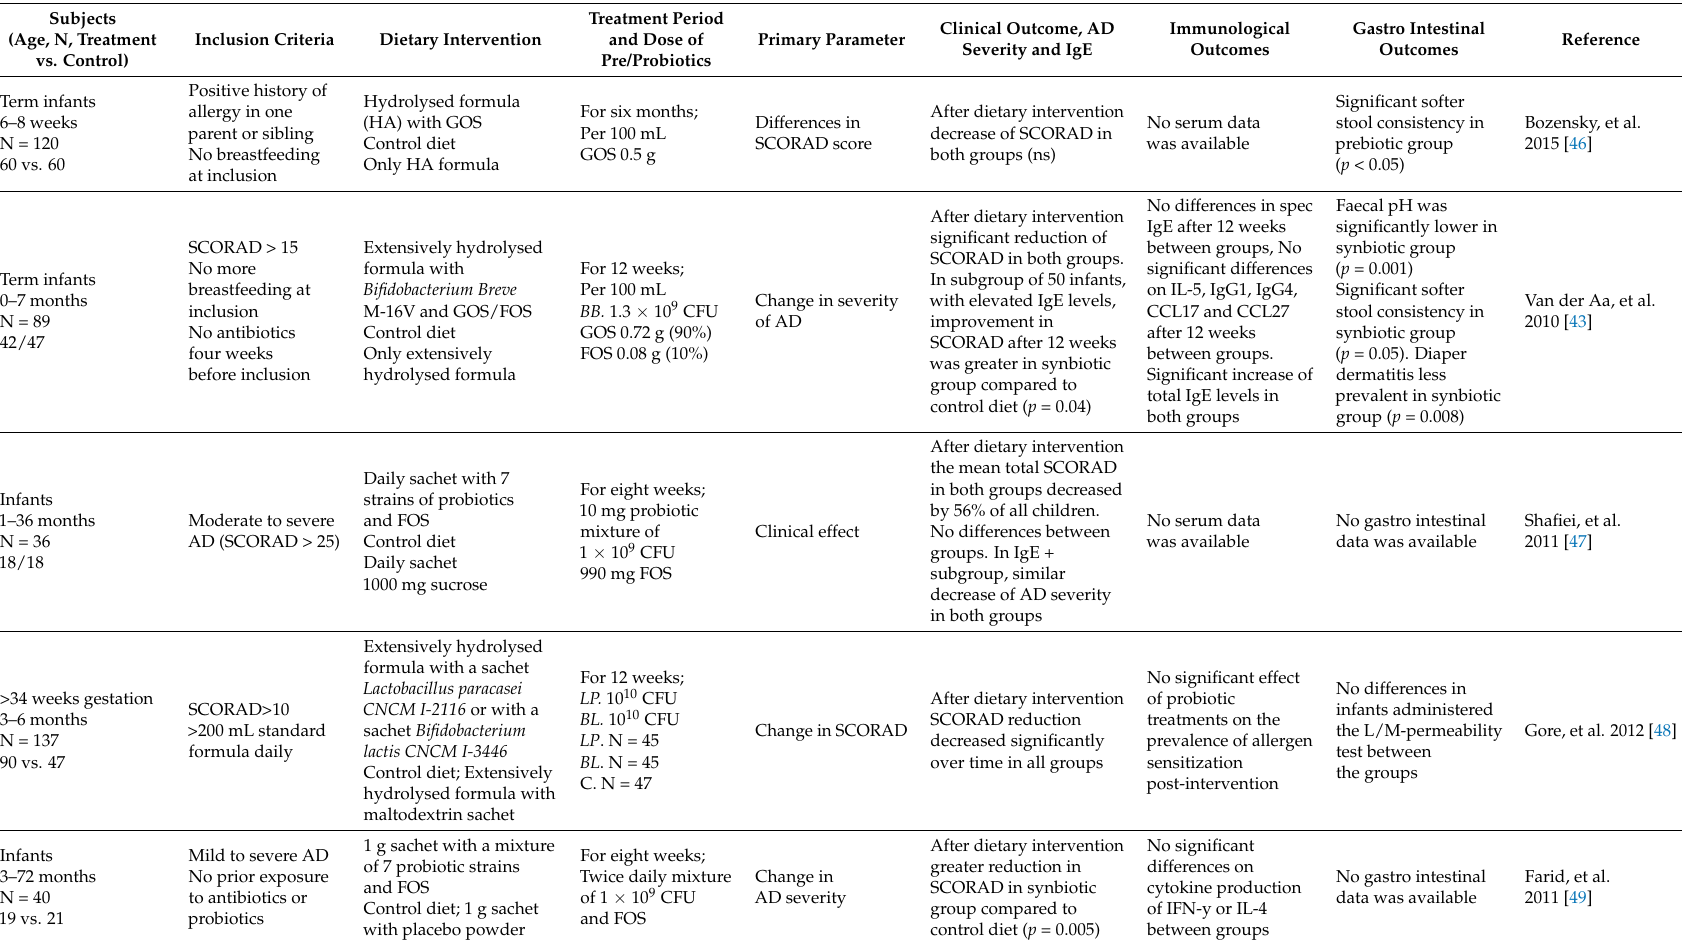
Table 1. Effects of microbial modulation in children with